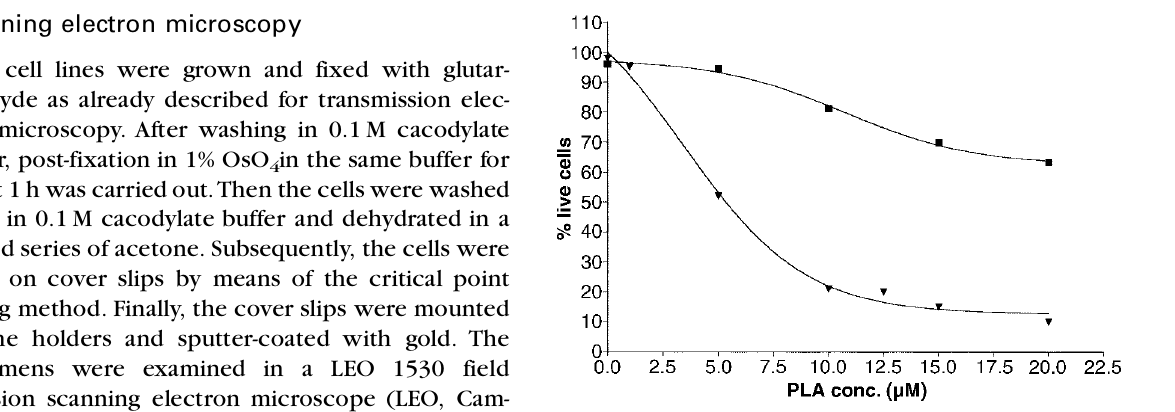
FIG. 1. Concentration dependence of the effect of poly- L -arginine (PLA conc.) on the viability of 16HBE14o– ( j ) and NHBE ( . ) cells. Data (expressed as percentage of live cells) represent the mean of 12 experiments, standard errors too small to